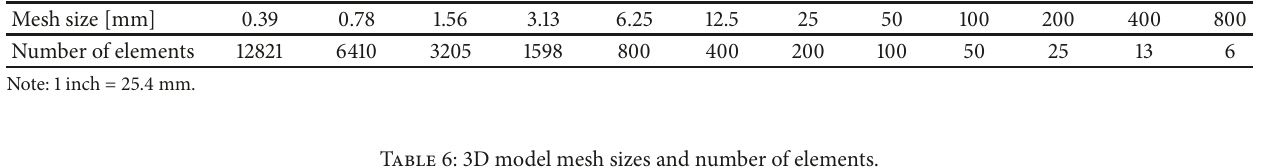
Table 5: Axisymmetric model mesh sizes and number of elements.